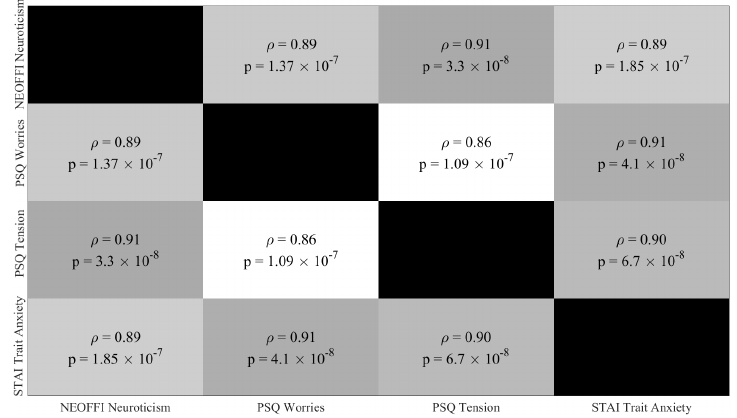
Figure A9. Pair-wise partial (Spearman) correlations between neuroticism (NEO-FFI), worries (PSQ), tension (PSQ), and trait anxiety (STAI-G-X2) for all 26 HIGH 14 LOW stress-susceptible participants. These participants include the younger females and older females and males participants that were later discarded from further analysis in our study due to their very low number in these samples of 26 HIGH and 14 LOW stress-susceptible